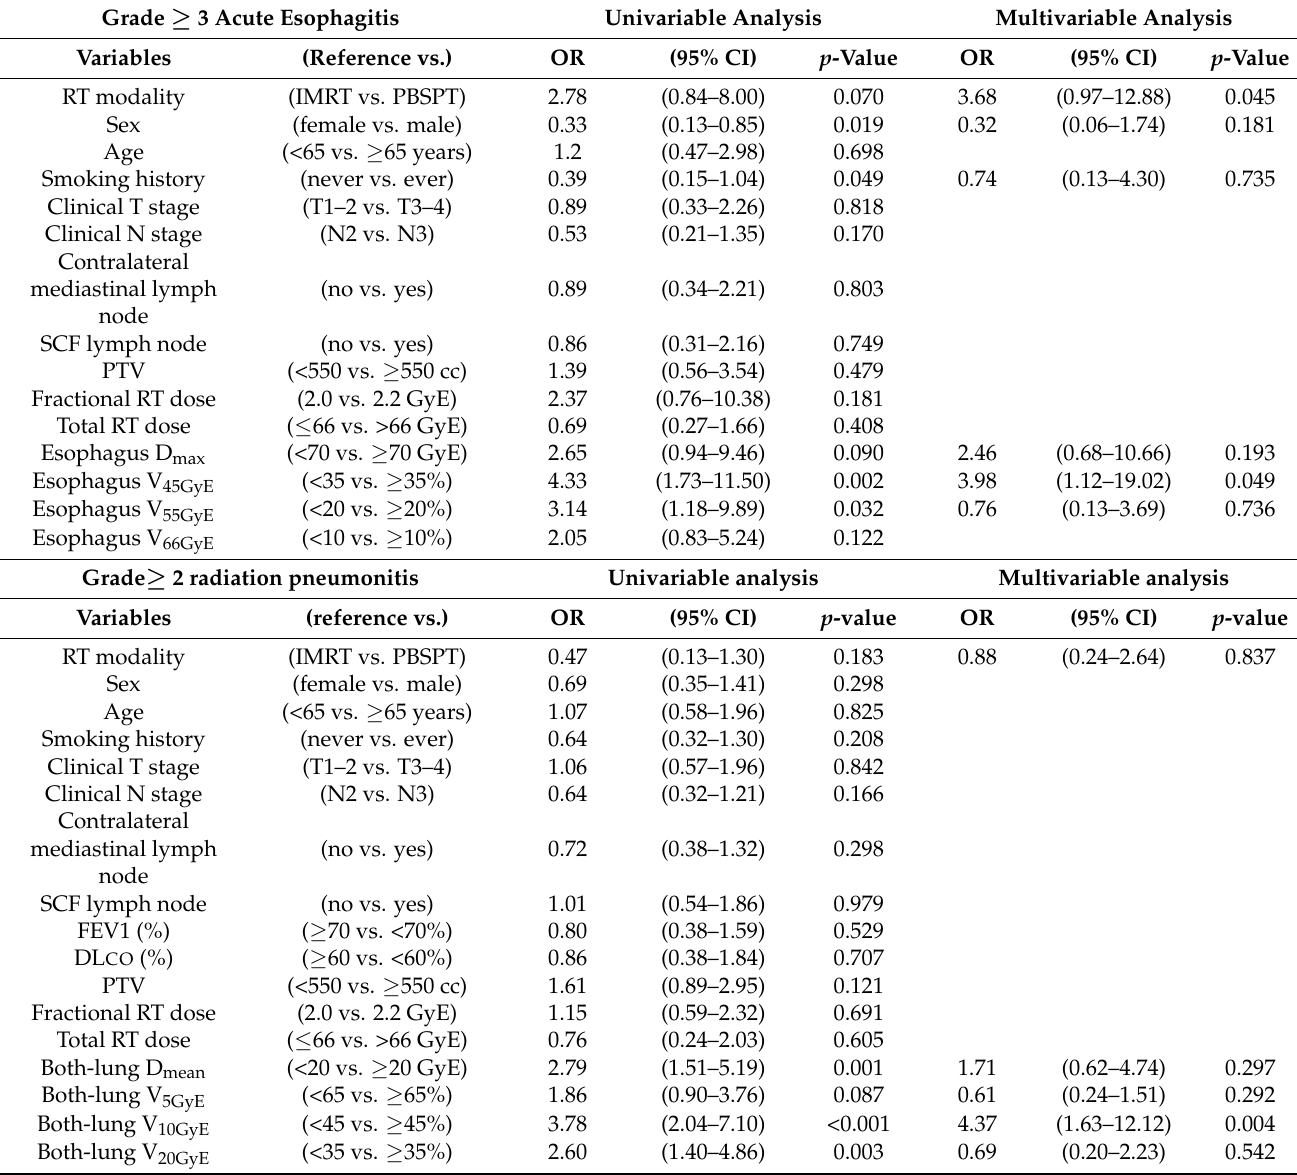
Table 4. Prognostic factors for grade ≥ 3 acute esophagitis and grade ≥ 2 radiation